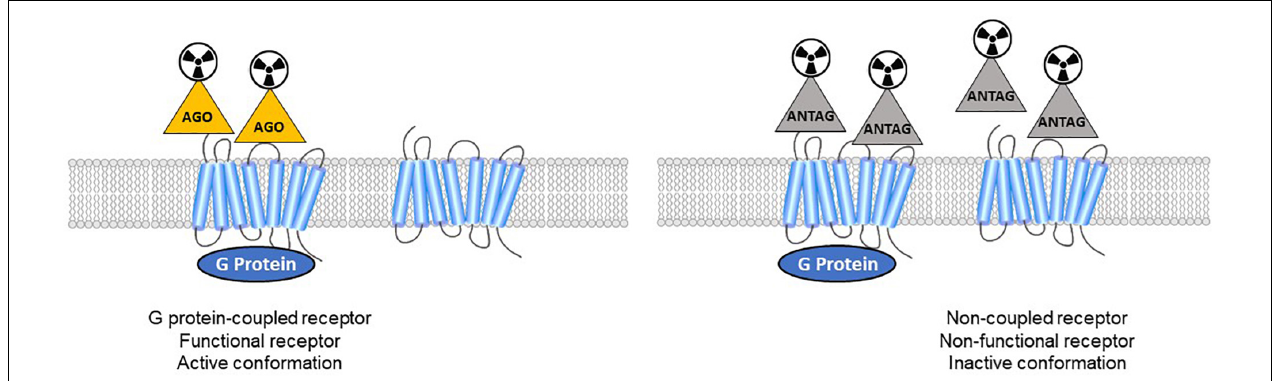
FIGURE 1 | Antagonist radioligands bind both coupled and non-coupled GPCRs with the same affinity. Agonist radioligands discriminate high-affinity (active GPCRs) versus low-affinity sites (inactive